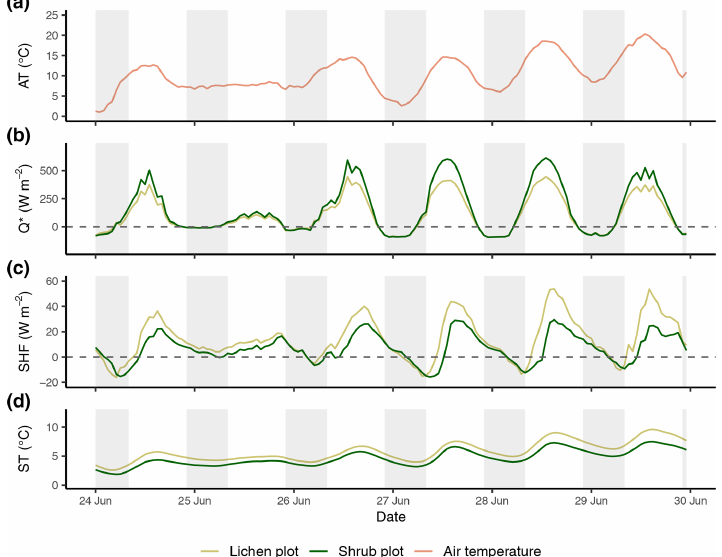
Figure E1. Time series of the reference air temperature (a) , net radiation (b) , soil heat flux (c) and soil temperature (d) of the first set of paired plots of the field season of 2019. Time series are constructed with hourly averages. Shaded areas indicate nighttime (22:00–08:00LT).